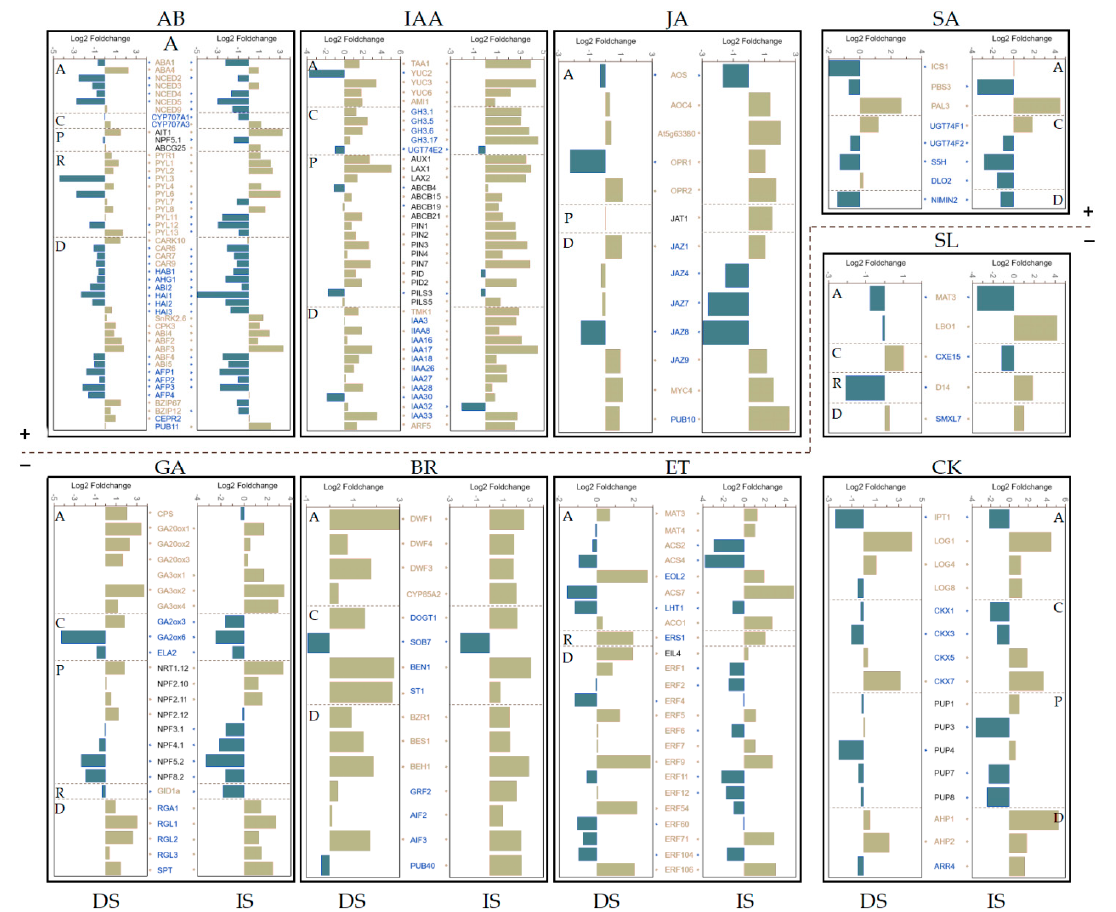
Figure 5. Comprehensive analysis of the influence of DOG1 on the expression of a particular gene in each phytohormone. The histogram shows expression alteration of the up- or down-regulated DEGs in dog1–2 in the indicated phytohormone pathway. Gene name in yellow or blue denotes that the gene plays a positive or negative role in homeostasis or signal transduction, respectively. *, p < 0.05. The dashed line divides the phytohormones into two classes: “+” denotes the phytohormones that induce seed dormancy or inhibit seed germination; “ − ” denotes the phytohormones that release seed dormancy or promote seed germination. DS, dry seeds; IS, imbibed seeds. A, Anabolism; C, Catabolism; P, transPort; R, Receptor; D, transDucer.